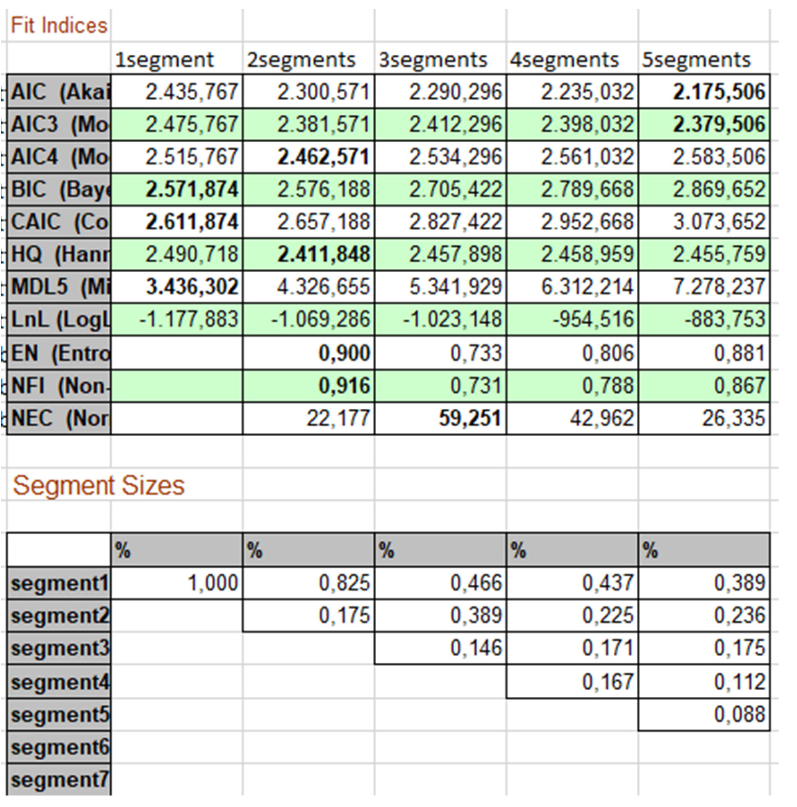
Figure 7. Example of a summary of the FIMIX results, mainly solutions with 1, 2 or 3